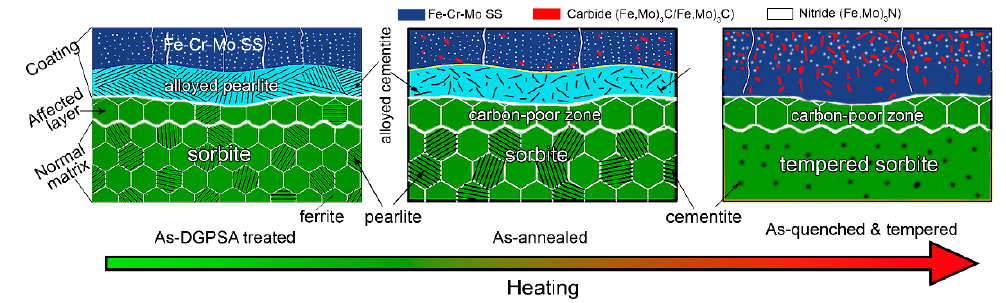
Figure 6. Schematic diagram illustrating the microstructure evolution during different treatments.